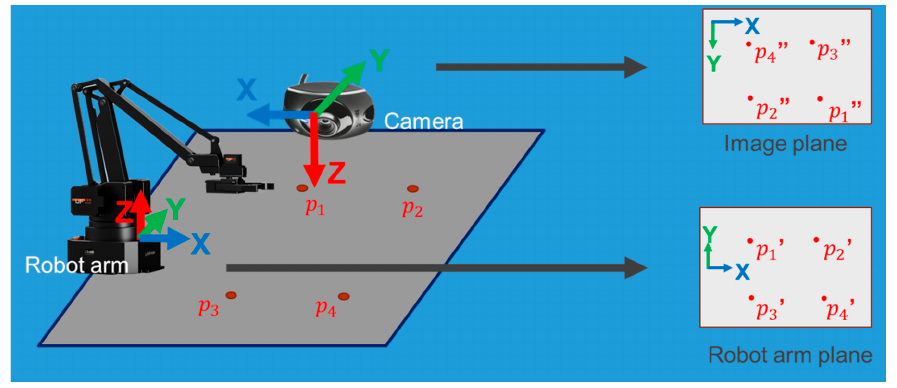
Figure 8. Diagram of hand-eye calibration.